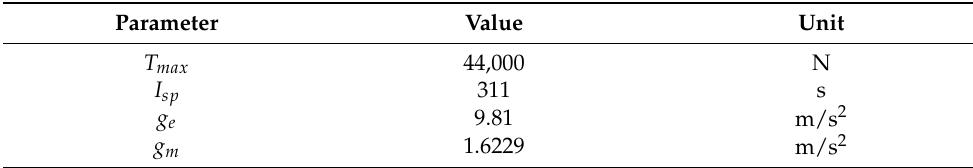
Table 2. The parameters for moon landing.